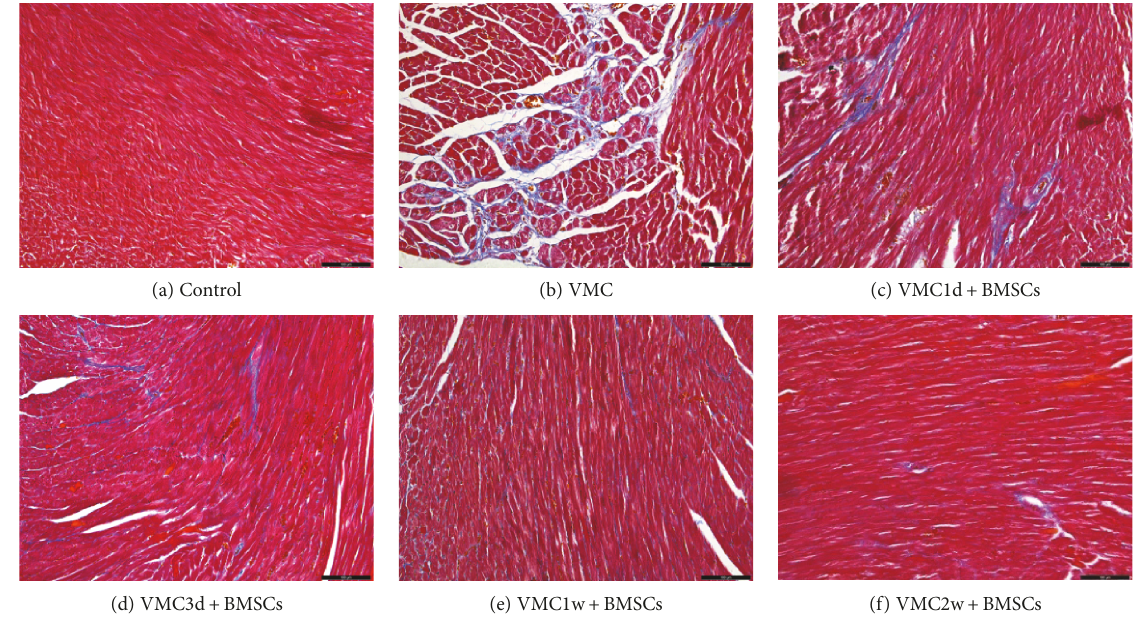
Figure 3: (a – f) Myocardial tissue collagen (blue) fi ber staining results (Masson ’ s trichrome staining, × 200, scale bar =100 μ m). (a) Control group. Histological fi ndings of myocardial tissues in 4 weeks after PBS intraperitoneal injection. (b) VMC, the myocarditis group. Histological fi ndings of myocardial tissues within 4 weeks after CVB3 intraperitoneal injection. (c – f) The BMSCs treatment subgroups. Histological fi ndings of myocardial tissues within 4 weeks after CVB3 intraperitoneal injection. Mice in the VMC1d +BMSCs, VMC3d+BMSCs, VMC1w+BMSCs, and VMC2w+ BMSCs subgroups were injected with BMSCs (1 × 10 6 cells of each mouse with 100ul PBS) through their tail vein on the 1st day, 3rd day, 1st week, and 2nd week, respectively, after they were infected by